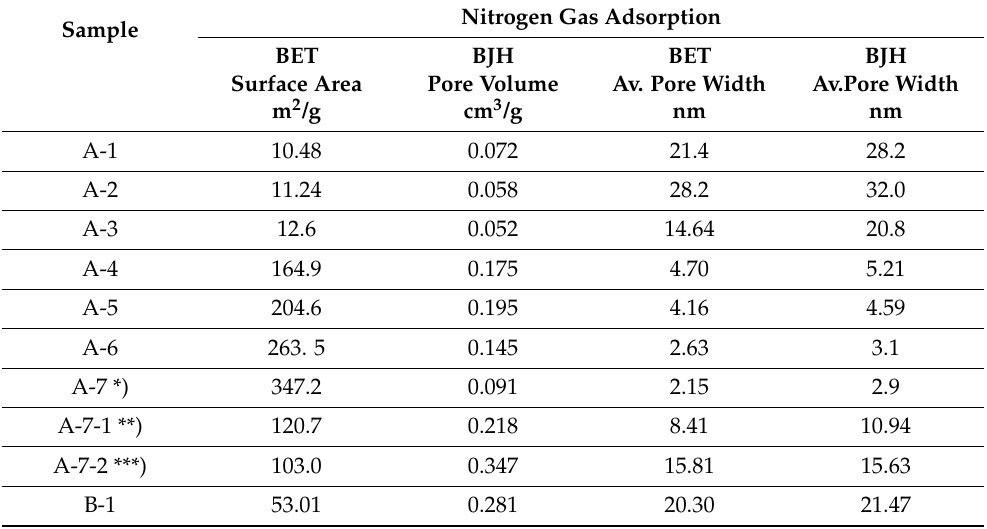
Table 4. Porosity results from nitrogen adsorption